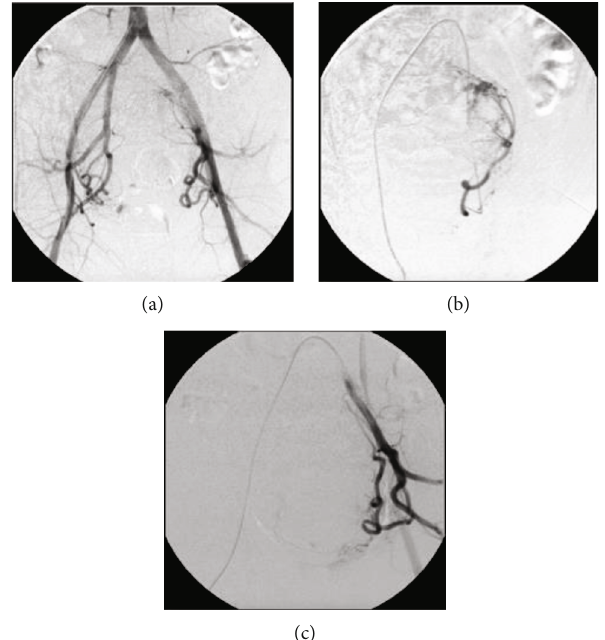
Figure 1: (a) Periprocedural digital subtraction angiography from UAE, showing aorta-iliac bifurcation and left (b) and right (c) uterine arteries before embolization. The procedure was performed on the left with four vials of Embospheres, two of 300-500 microns, one of 500-700 microns, and one of 700-900 microns. On the right, three vials were used, one of 300-500 microns, one of 500-700 microns, and one of 700-900